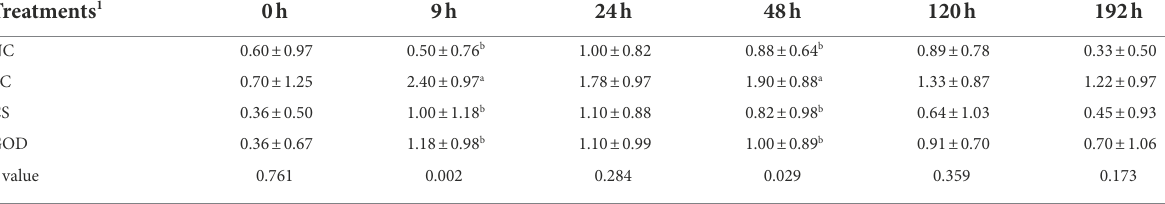
TABLE 4 Effect of dietary treatments on the fecal score in piglets post enterotoxigenic Escherichia coli (ETEC) challenge. Treatments 1